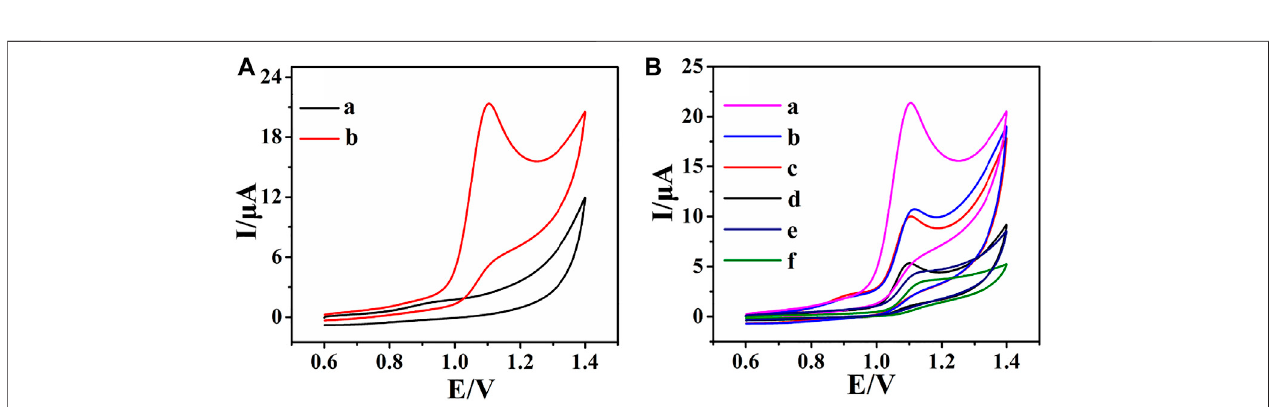
FIGURE 4 | CVs of rGO – TiO 2 – Au/GCE in the absence (a) and presence (b) of 0.2 mM ACV in 0.1 M PB solution (pH 6.0) (A) ; CVs of rGO – TiO 2 – Au/GCE (a), rGO – Au/GCE (b), rGO – TiO 2 /GCE (c), rGO/GCE (d), TiO 2 /GCE (e), and bare GCE (f) in 0.1 M PB solution (pH 6.0) containing 0.2 mM ACV (B) . Scan rate: 100 mV s − 1 .